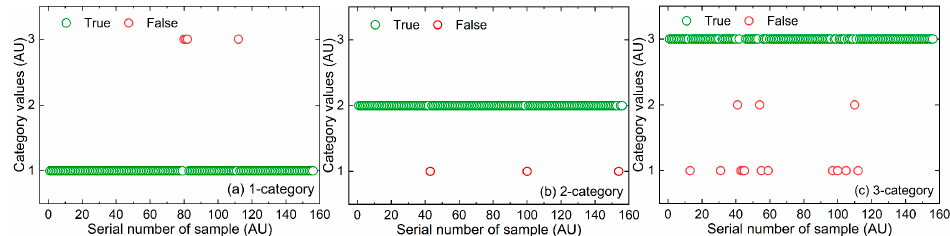
Figure 6. Schematic diagrams of the recognition effect of the optimal joint model based on three-model voting fusion for three categories of validation samples: ( a ) 1-category, ( b ) 2-category, ( c ) 3-category.